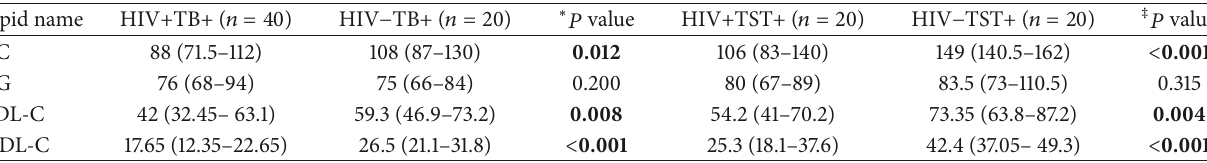
Table 3: Lipid profile levels (mg/dl) of active TB and latent TB coinfected with HIV compared to without HIV